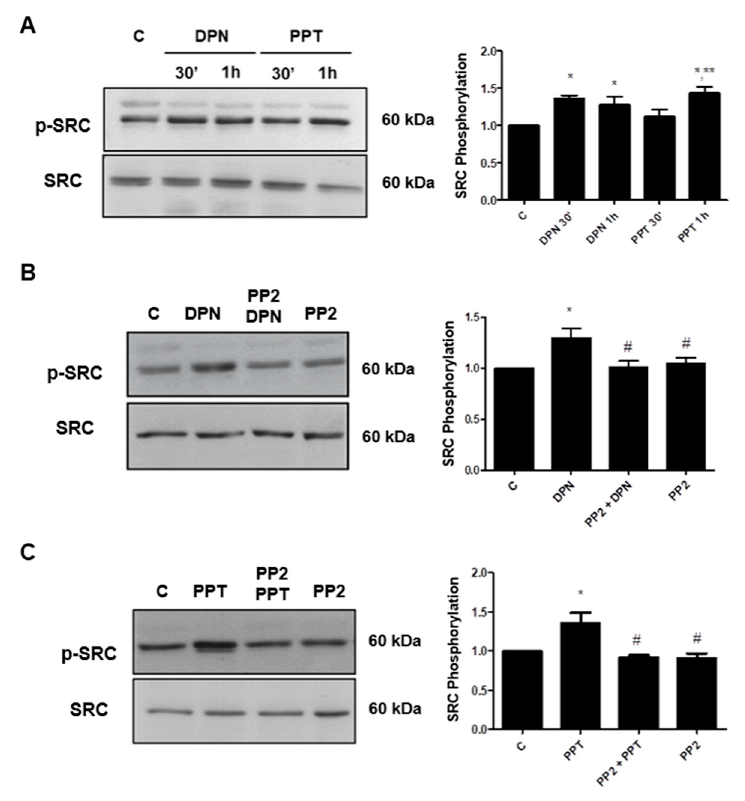
Figure 2. Effects of ER β - (DPN) or ER α -selective agonists (PPT) on SRC (Tyr419) phosphorylation in androgen-independent prostate cancer cells PC-3. The cells were incubated in the absence (C, control) and presence of DPN or PPT (10 nM) for 30 min and 1 h at 37 ◦ C ( A ). The cells were incubated in the absence (C, control) and presence of DPN (10 nM) for 30 min ( B ) or PPT (10 nM) ( C ) for 1 h. The cells were also pre-treated with the selective inhibitor for SRC-family kinases (PP2 5 nM, 30 min) and then incubated or not with DPN for 30 min ( B ) or PPT for 1 h ( C ). Phosphorylated SRC (p-SRC) and total SRC were detected by Western Blot. The immunoassay was performed with anti-phosphorylated SRC (upper panel) and total anti-SRC antibodies (lower panel). The relative position of SRC was determined from the molecular weight standard. The data shown are representative of four to six independent experiments. Densitometric analysis was performed of the results obtained from each band, normalized by the expression of the total SRC and expressed in relation to the control (C = 1). Results were plotted (mean ± SEM) of four to six independent experiments. * Significantly different from control (C) ( p < 0.05, ANOVA and Newman-Keuls). ** Significantly different from PPT 30 min ( p < 0.05, ANOVA and Newman-Keuls). # Significantly different from DPN for 30 min or PPT for 1 h ( p < 0.05, ANOVA and Newman-Keuls).